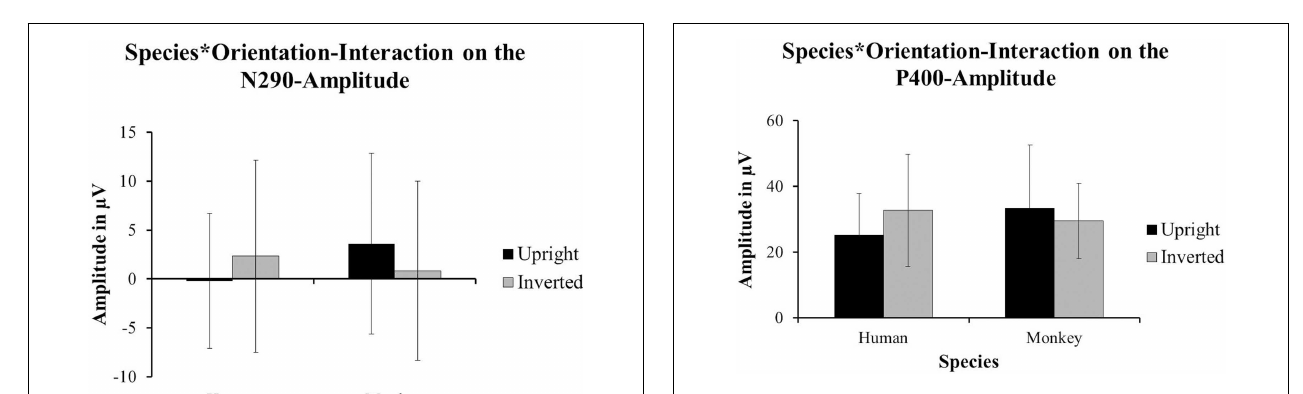
FIGURE 4 |The data from our group of 1-year-olds showed a significant interaction between Species and Orientation impacting on the amplitude of the P400 [ F (1, 14) = 5.39, p = 0.036]. The inverted human faces ( ± SD) yielded the more positive responses than the upright human faces ( ± SD). However, the upright monkey-faces ( ± SD) yielded the more positive responses compared to the inverted monkey-faces ( ± SD).